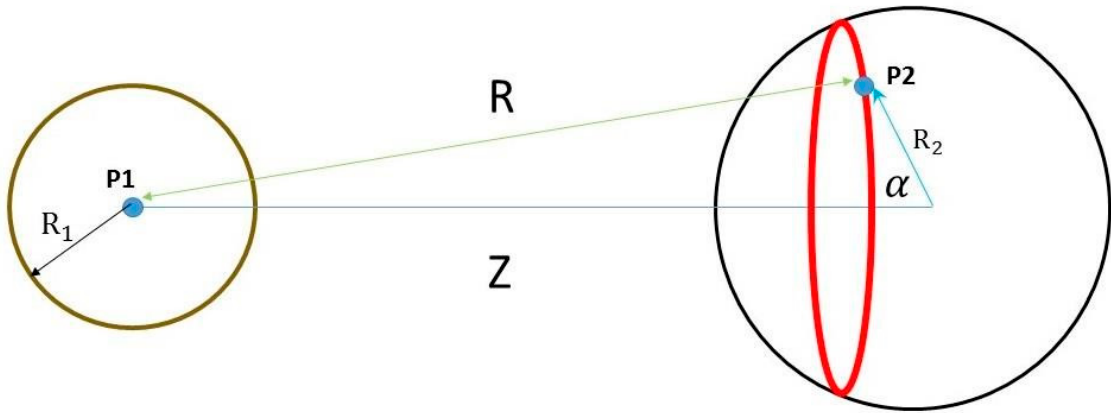
Figure 1. Two charged spheres : left circle represents a charged sphere of radius R 1 and its total surface charge is Q 1 . Right circle represents a charged sphere of radius R 2 and its total surface charge is Q 2 . The distance between the centers of the two spheres is Z . The potential created by the left charged sphere is calculated at point P2.